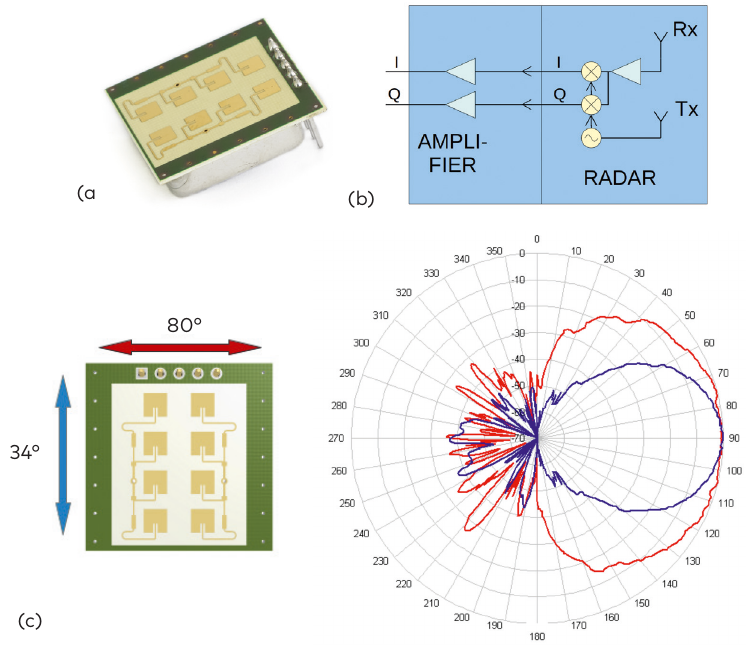
Figure 15. Selected transceiver for radar sensor: (a) appearance; (b) block diagram; (c) antenna system diagram